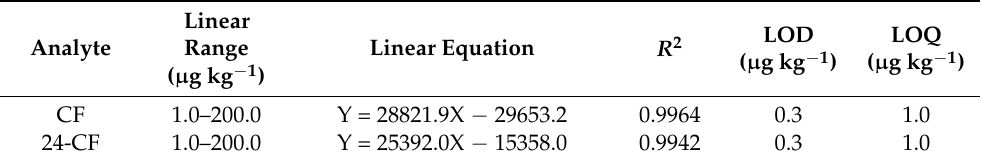
Table 1. The linear range, calibration equation, correlation coefficients ( R 2 ), limit of detection (LOD) and limit of quantification (LOQ) for CF and 24-CF.